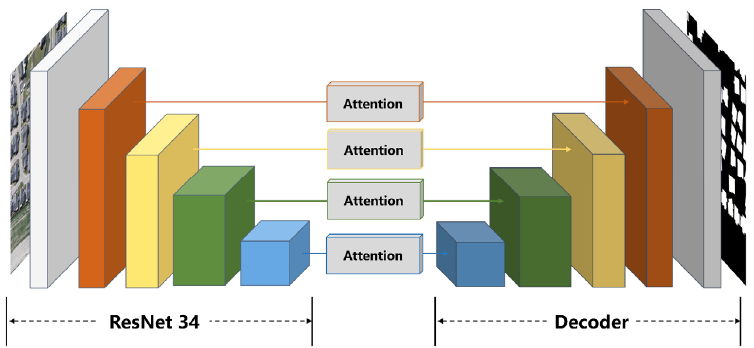
Figure 3. Structure of proposed network.